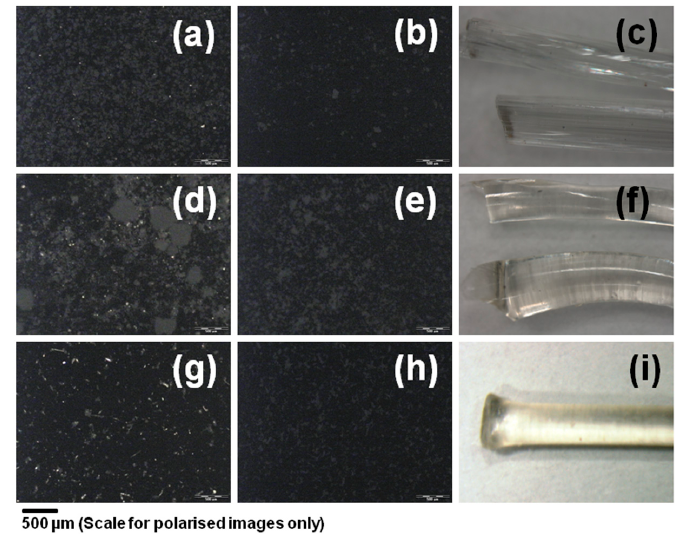
Figure 3. Polarized light photomicrographs of ( a ) 10% TAC PVP-VA 64 physical mixture, ( b ) 10% TAC PVP-VA 64 extruded and milled powder, ( d ) 10% TAC Soluplus physical mixture ( e ) 10% TAC Soluplus extruded and milled powder ( g ) 10% TAC HPC physical mixture, ( h ) 10% TAC HPC extruded and milled powder, and optical photomicrograph of Extruded strands of ( c ) PVP VA 64 ( f ) Soluplus and ( i ) HPC containing 10% w / w